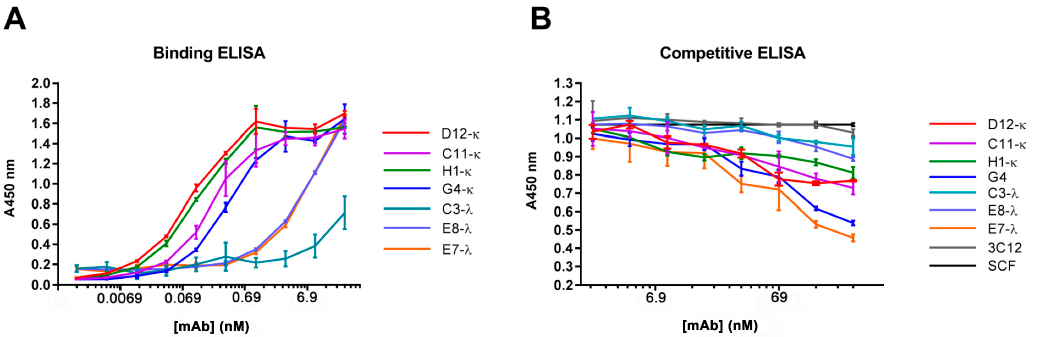
Figure 4. ELISA for anti-canine CD117 fully reformatted IgG1 mAbs. ( A ) The ELISA plate was coated with recombinant canine CD117-hFc, then probed with the seven anti-canine CD117 IgG1 mAbs. Bound mAbs were detected using horse radish peroxidase (HRP) conjugated anti- κ and anti- λ secondary antibodies. ( B ) The ELISA plate was coated with recombinant canine CD117-hFc and then probed with different concentrations of anti-canine CD117 mAbs pre-mixed with 50-ng/mL recombinant canine stem cell factor (SCF)-His. The presence of SCF was detected using anti-His HRP secondary antibodies. Error bars represent standard